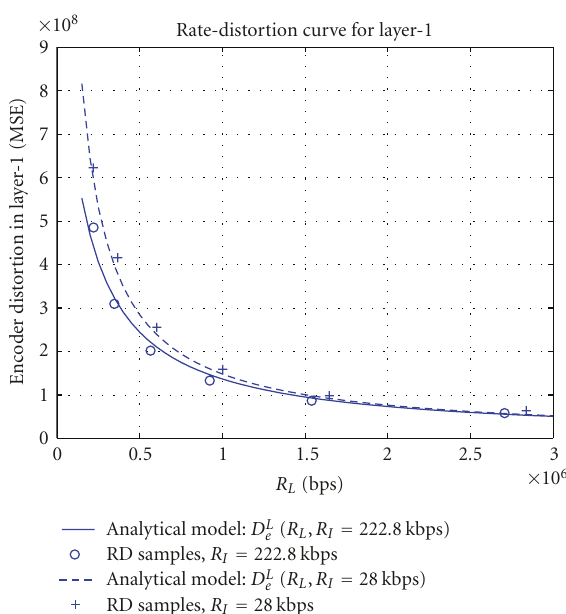
interest. The average di ff erence between analytical models and RD samples for the “Rena” video are 3.62%, 7.60%, and 9.19% for layer 0, 1, and 2, respectively, and those of the “Soccer” video are 1.00%, 5.87%, and 8.89%. Thus, for both of the videos, which have di ff erent characteristics, approximates the RD samples